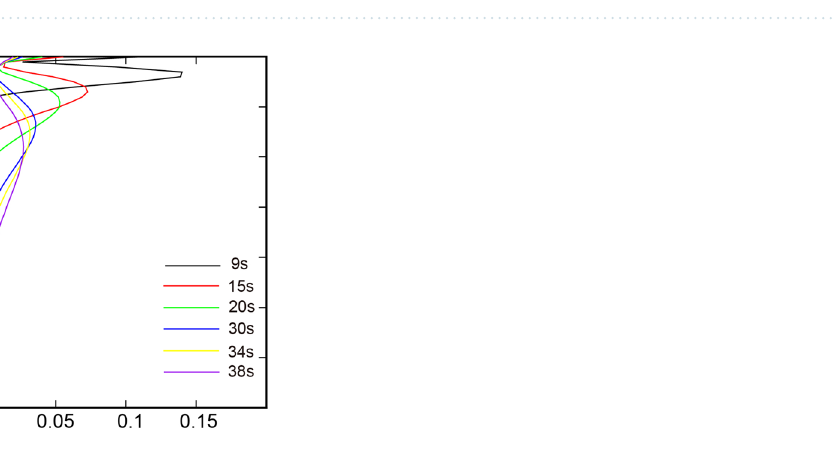
Figure 1. Left panel: location of the study region; red line: boundary of the NCC. Right panel: distribution of seismic stations; the black triangles indicate the seismic stations, whereas the blue lines indicate the S-wave velocity profiles. The study area is located in the central part of the NCC, including the suture zone between the EB and WB. The white lines are the boundaries of geological units (the figure was generated by Chuansong He using Generic Mapping Tools (https:// www. gener ic- mappi ng- tools. org/)).